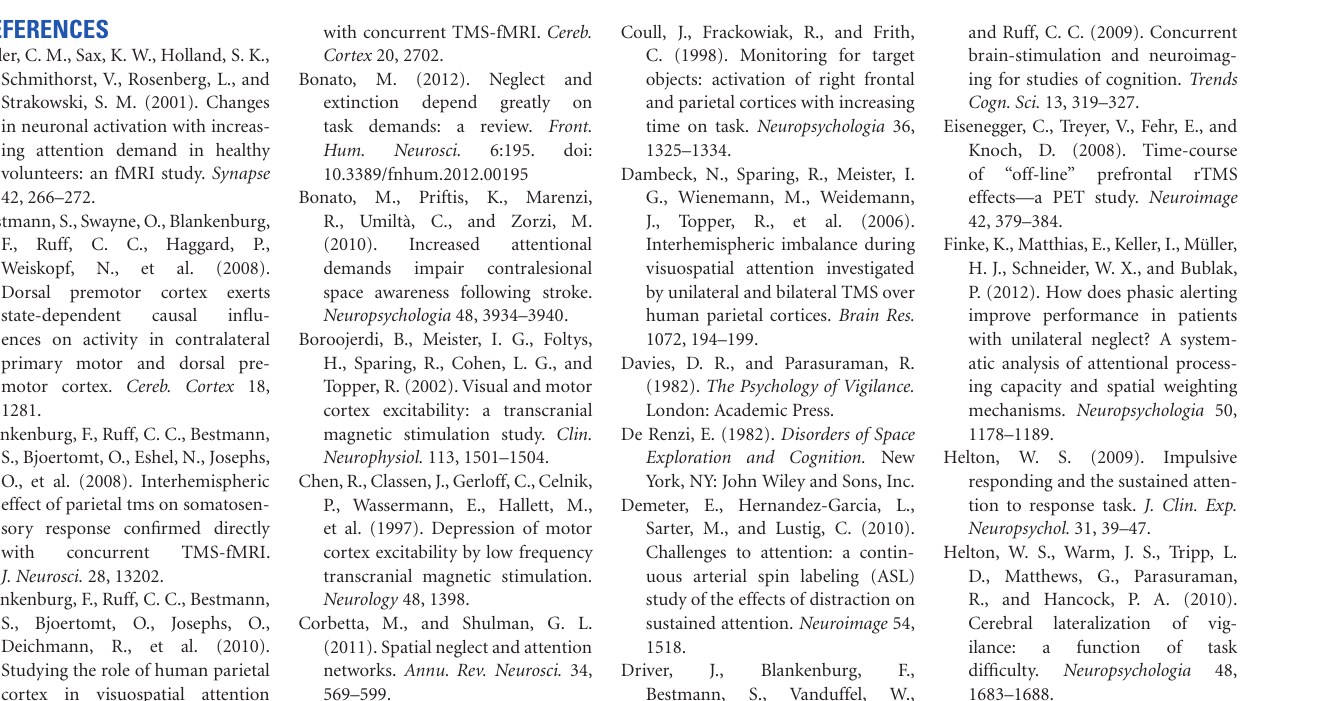
FIGURE 4 | (A–J) Omission and commission errors over time whilst performing two types of task. Errors were averaged at each period which consists of 20 tests (Error bars indicates SEM). Only omission errors significantly increase on the spatial task when rTMS was